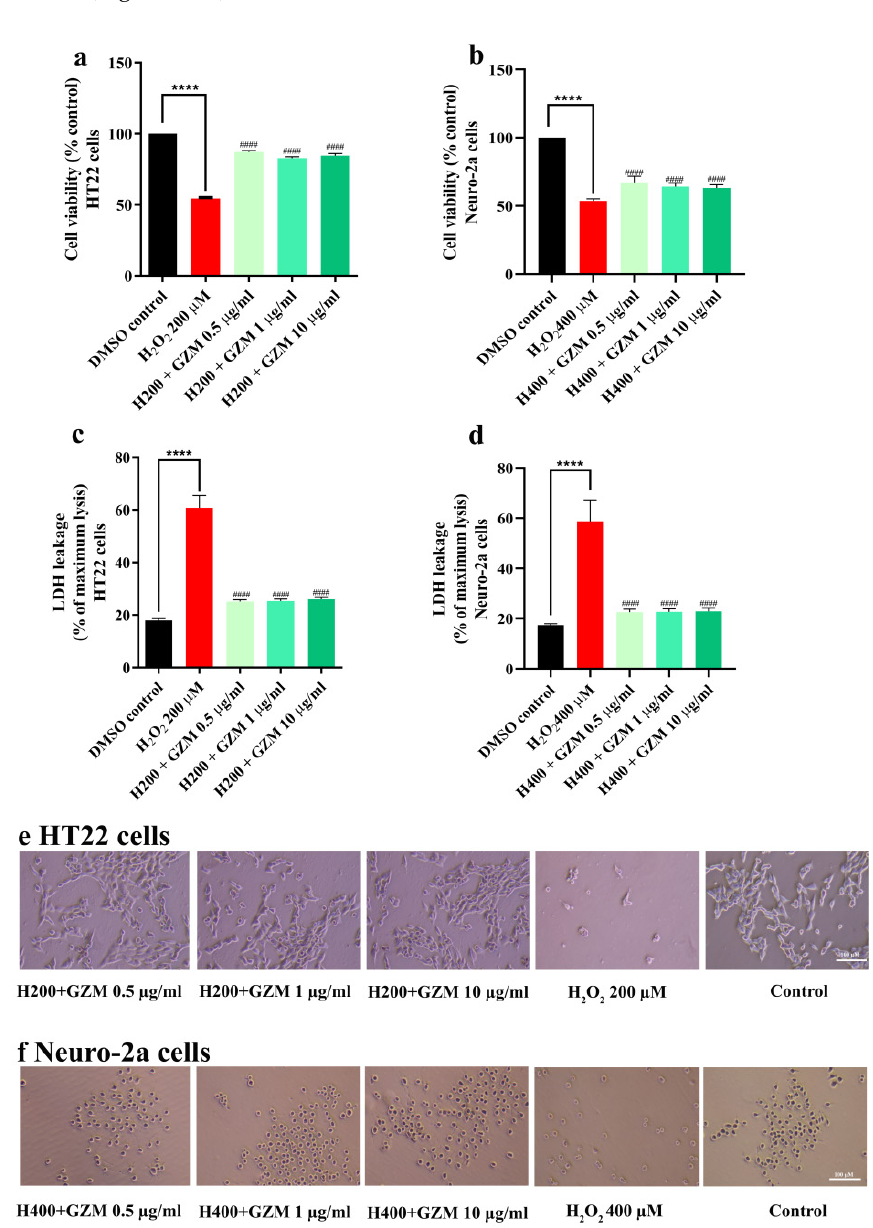
Figure 2. Neuroprotective effect of GZM extract against H 2 O 2 -induced toxicity in HT22 and Neuro- 2a cells. MTT and LDH methods were used to analyze cell viability of HT22 ( a , c ) and Neuro-2a cells ( b , d ) after treatment with varying concentrations of GZM extract. Cell morphology of HT22 ( e ) and Neuro-2a ( f ) were observed under a light microscope (5 × magnification). ((H200 and H400 corresponds to 200 and 400 µ M H 2 O 2 , respectively; n = 3). (**** p < 0.0001, DMSO control vs. H 2 O 2 treatment alone; #### p < 0.0001, H 2 O 2 treatment alone vs. H 2 O 2 and GZM extract treatment. The details of statistical values are provided in Table S3 (Supplementary Materials).